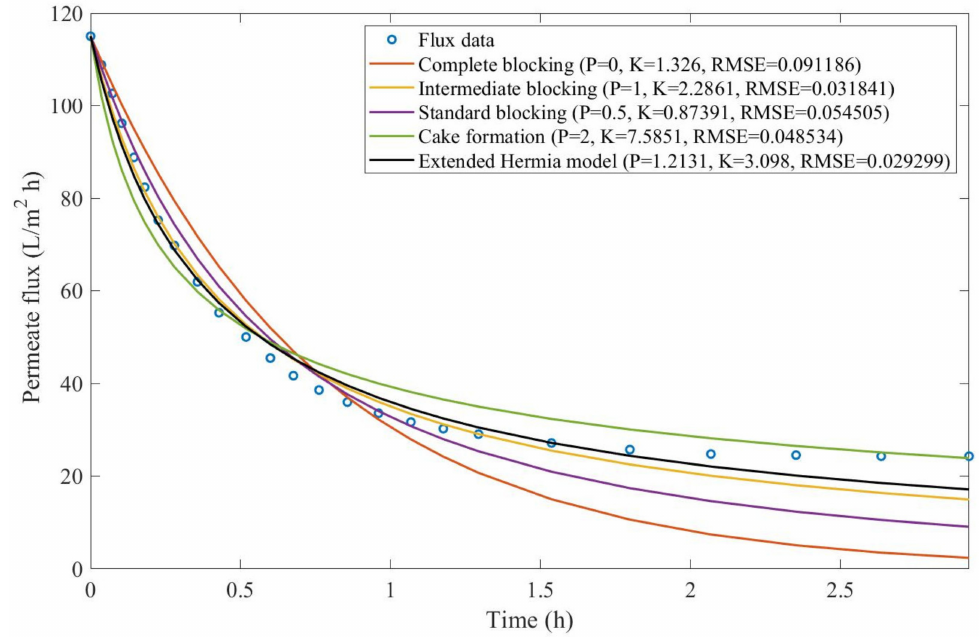
Figure A14. Model fitting for corn syrup microfiltration with CM05 at 2.31 m/s and 103.42 kPa considering the four original pore-blocking mechanisms and the extended Hermia model (2). Example 3: